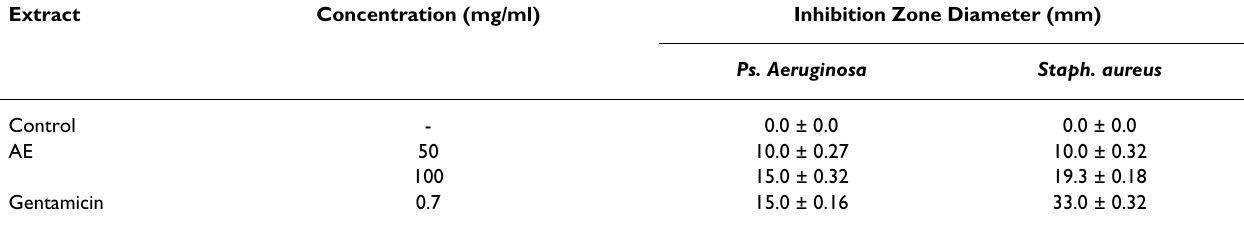
Table 1: Antimicrobial activity of the extract Extract